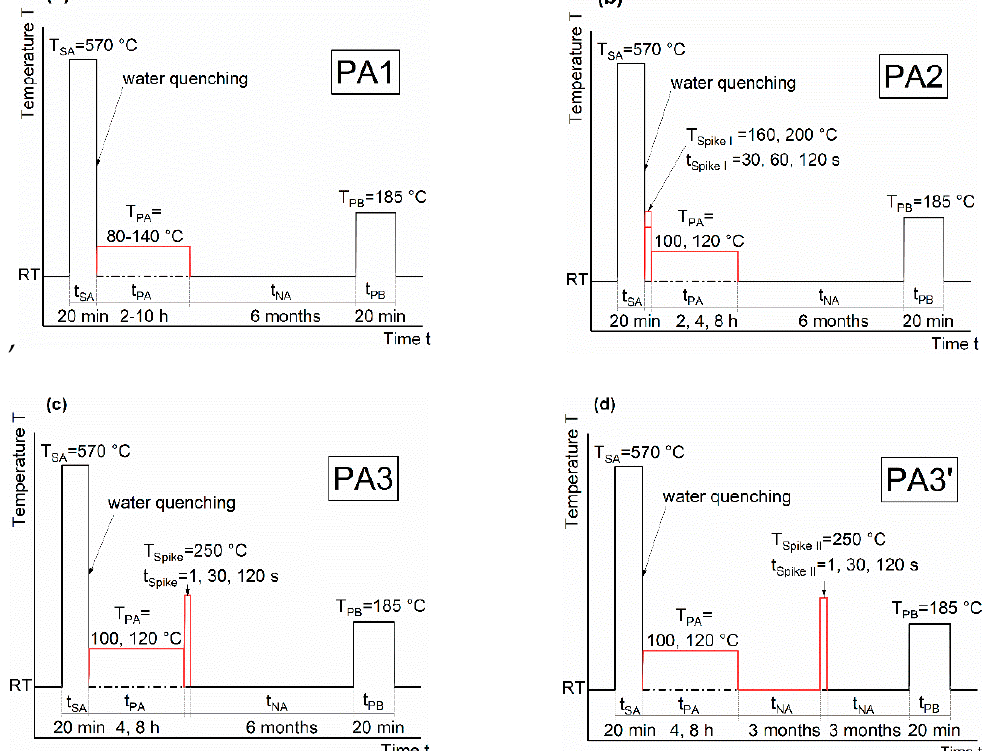
Figure 1. Overview of the applied pre-aging treatments PA1 ( a ), PA2 ( b ), PA3 ( c ), and PA3’ ( d ). Note that for each treatment, a reference was treated without pre-aging “As-Quenched” (dot-dashed black line).